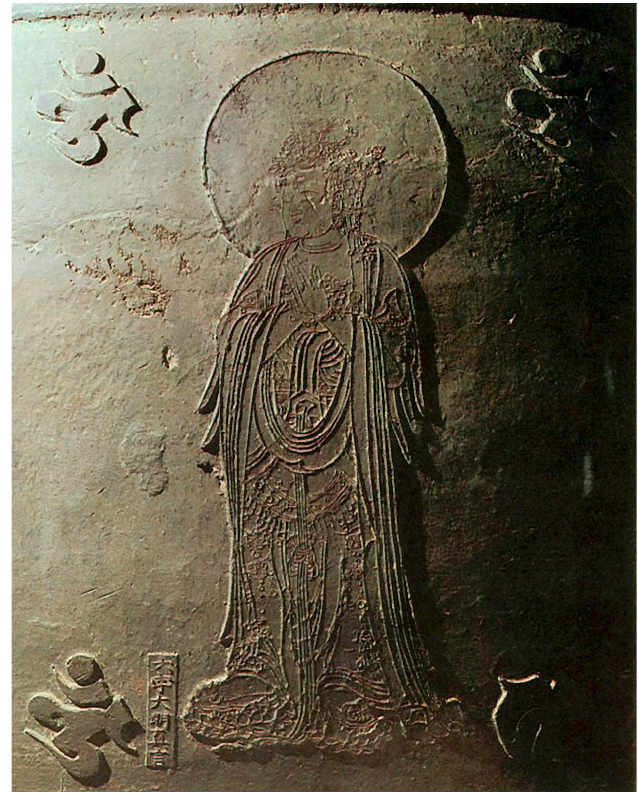
Figure 20. Detail of the Pongs ŏ nsa Bell.